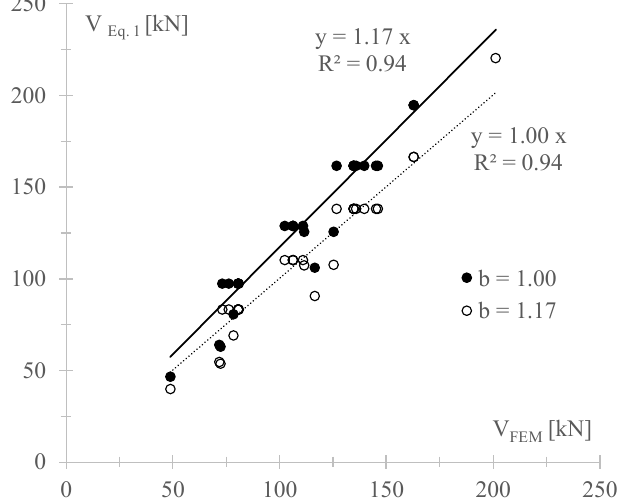
Figure 15. Theoretical predictions of the shear resistance provided by Equation (1) vs. FEM numerical values.